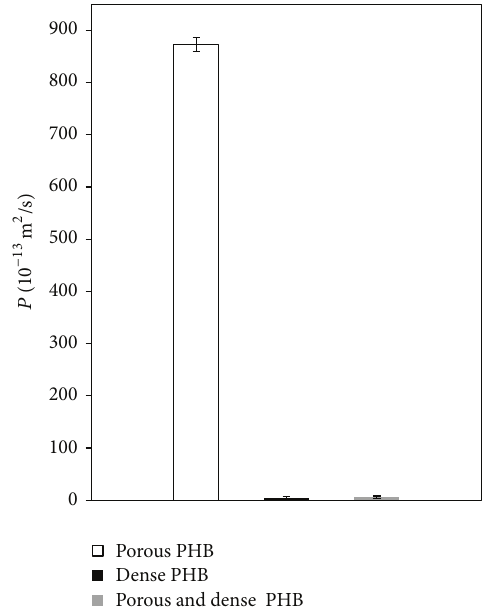
Figure 6: Water permeability of porous, dense (nonporous), and bilayer films casted from template emulsions with 10% (v/v) of water and 2.9% (w/v) of Li 2 SO 4 in the emulsion template. The permeability was normalized against the film thickness. Error bars indicate min/max deviation ( 𝑛 = 2 -3).